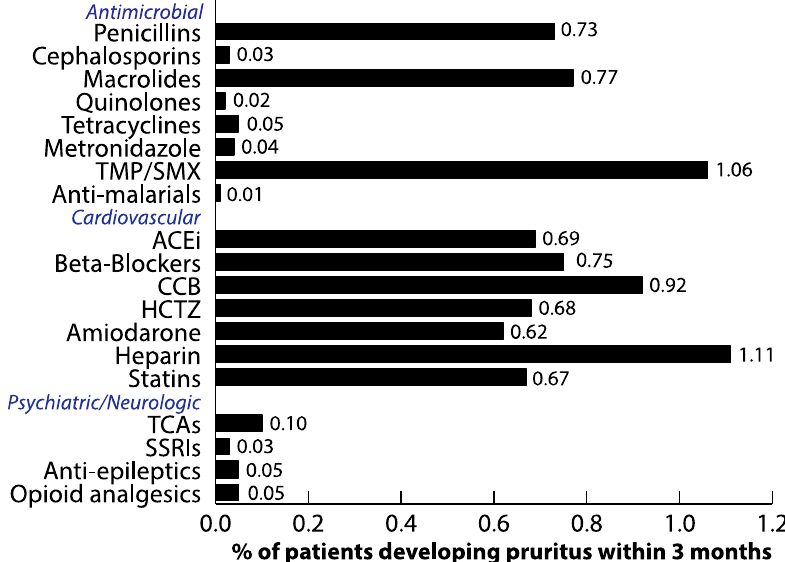
Figure 1. Frequency of pruritus after receiving drugs. 3.3. Rates of Drug Eruption among Patients with Pruritus Subsequent to Receiving Drug